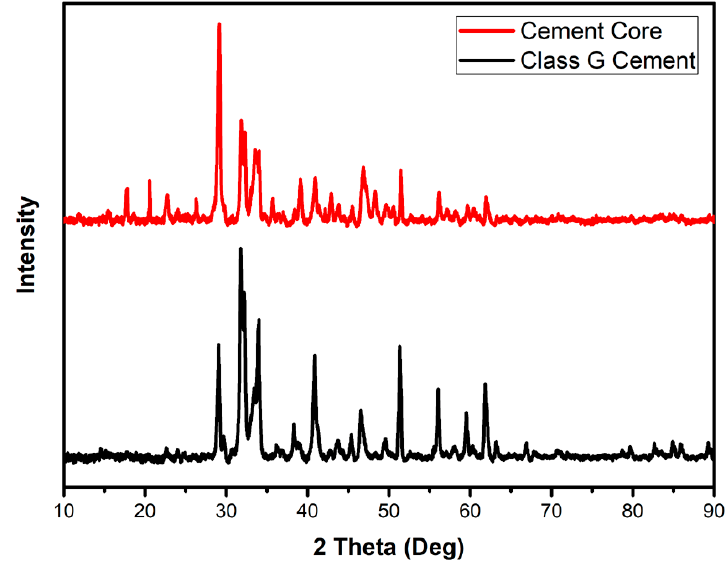
Figure 9. XRD pattern of cement and cement core.